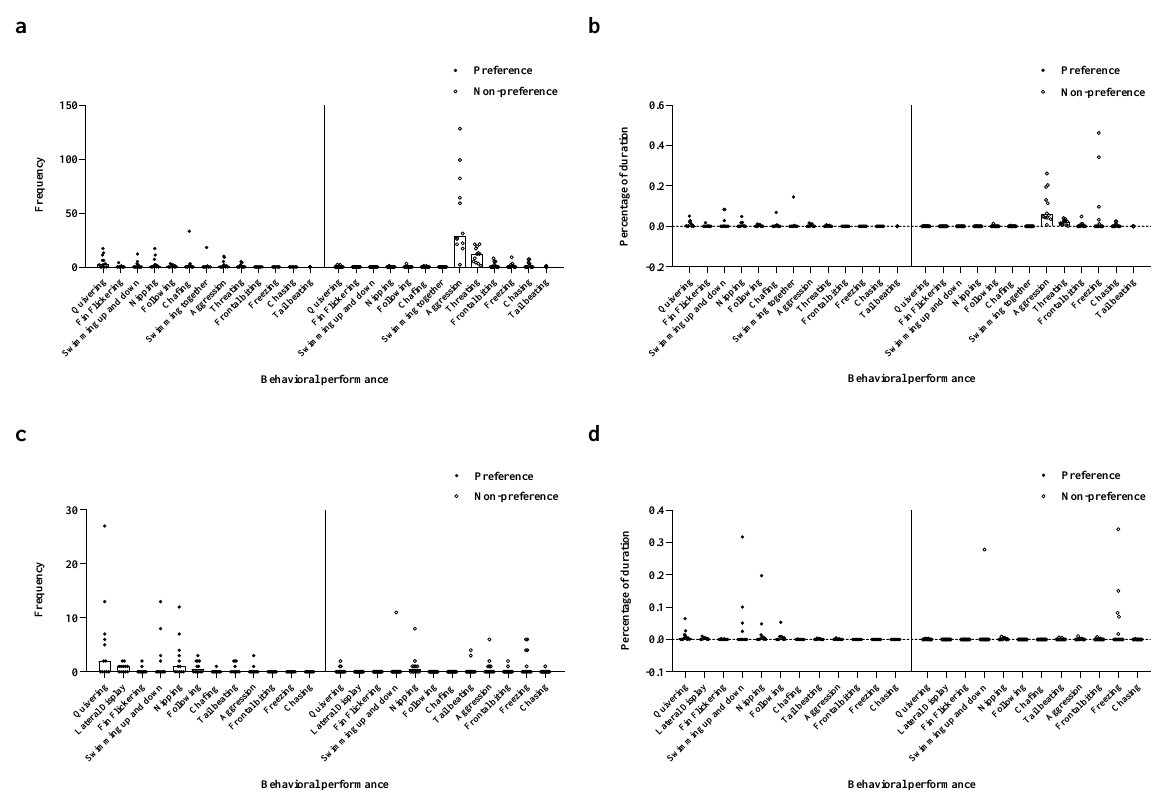
Figure 5. The behavioral intention of male and female fish in Experiment 2. ( a ) Frequency of female’s be- havioral performance; ( b ) Proportion of the duration of behavioral performance in females; ( c ) Frequency of male’s behavior performance; ( d ) Proportion of the duration of behavior performance in